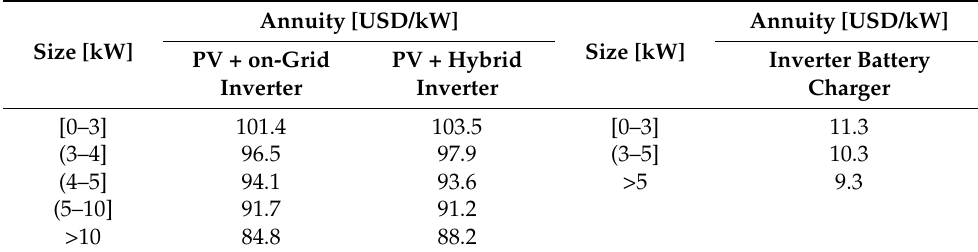
Table 4. Economies of scale for microgrid assets.